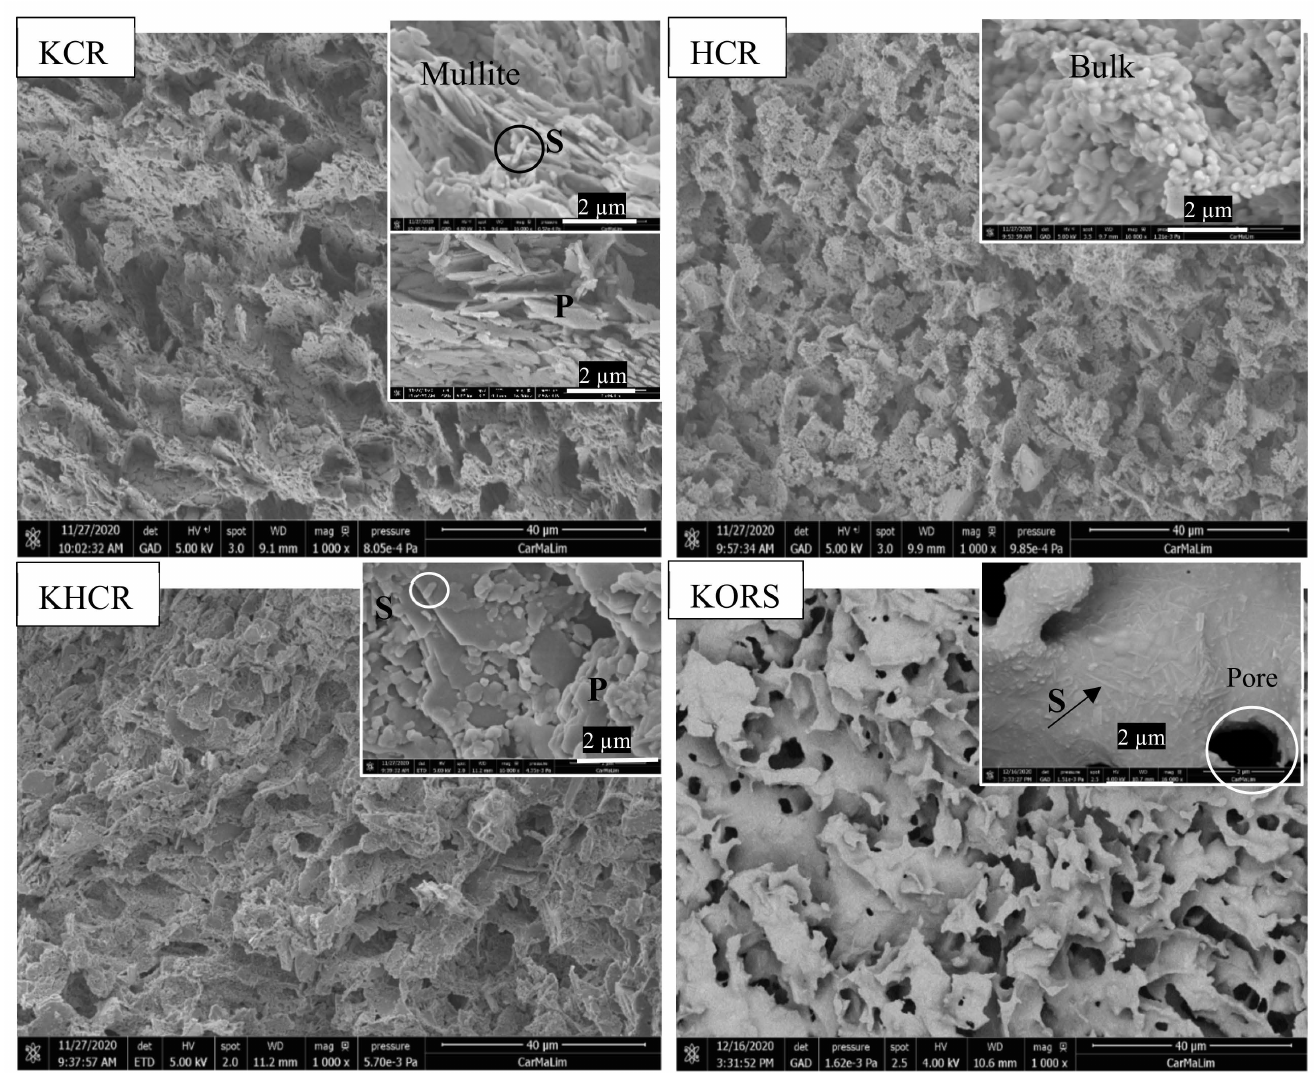
Figure 9. SEM images realized in the section of the manufactured porous ceramics (discs sintered at 1200 ◦ C. P = Primary mullite; S = Secondary